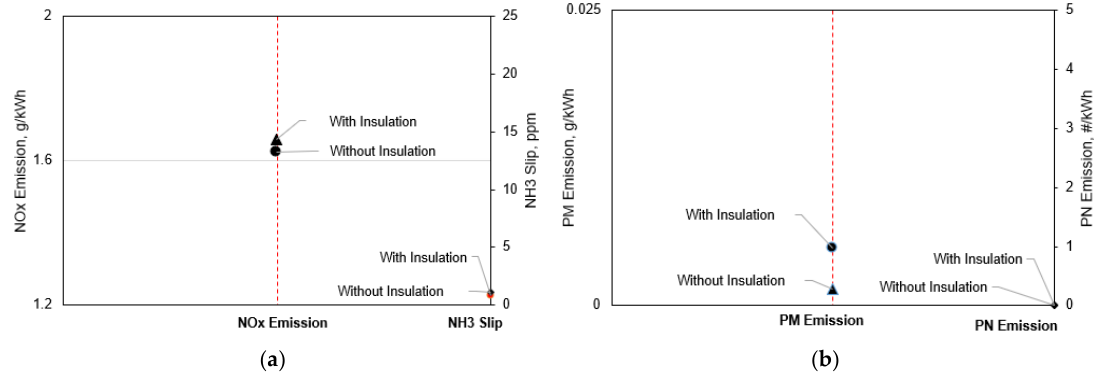
Figure 2. Nonroad transient cycles (NRTC) emission results. ( a ) NOx Emission and NH 3 Slip Results, ( b ) PM Emission and PN Emission Results